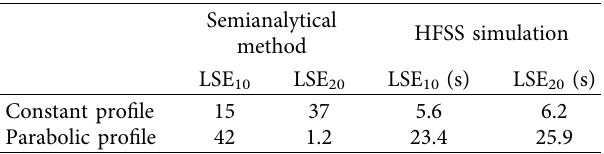
Table 1: Computation time comparison of the semianalytical method and the HFSS